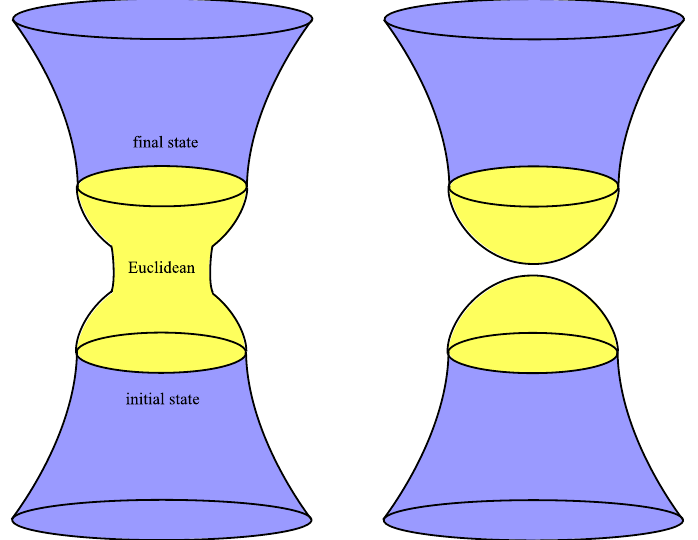
Figure 1. Left : Euclidean path integral that connects from the initial state to the final state. Right : If two states are disconnected at the Euclidean manifold, one can consider a wave function for the only final